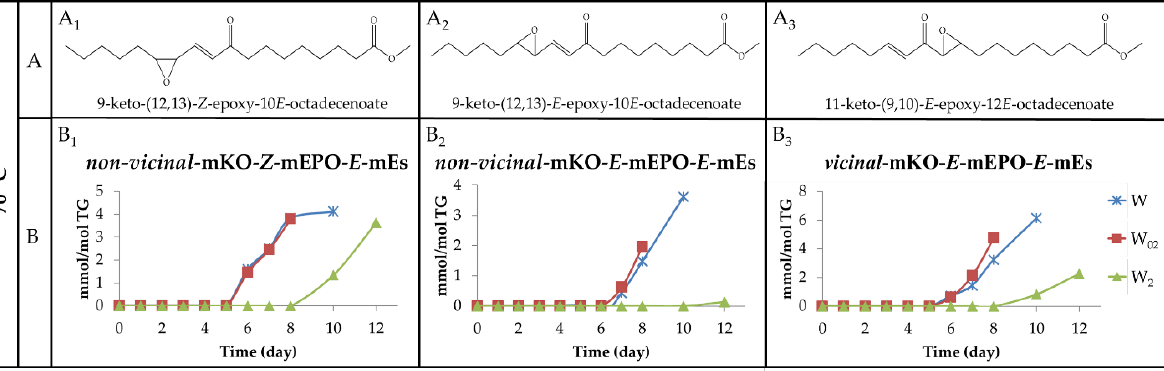
Figure 12. ( A ) Structure of: ( A 1 ) 9-keto-(12,13)- Z -epoxy-10 E -octadecenoate as an example of non- vicinal mKO- Z -mEPO- E -mE; ( A 2 ) 9-keto-(12,13)- E -epoxy-10 E -octadecenoate as an example of non- vicinal mKO- E -mEPO- E -mE; ( A 3 ) 11-keto-(9,10)- E -epoxy-12 E -octadecenoate as an example of vicinal mKO- E -mEPO- E -mEs. ( B ) Evolution of the concentration expressed as mmol/mol TG, of: ( B 1 ) non- vicinal mKO- Z -mEPO- E -mEs, ( B 2 ) of non-vicinal mKO- E -mEPO- E -mEs, and ( B 3 ) and of vicinal mKO- E -EPO- E -mEs, in walnut oil samples having different enrichment level in α T (W, W 02 and W 2 ), submitted to 70 ◦ C up to advanced stages of the oxidation